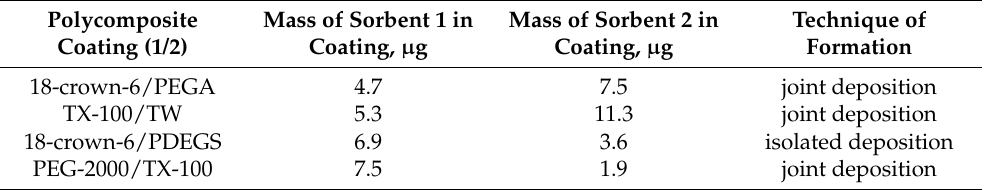
Table 5. The composition of the polycomposite coating for the used